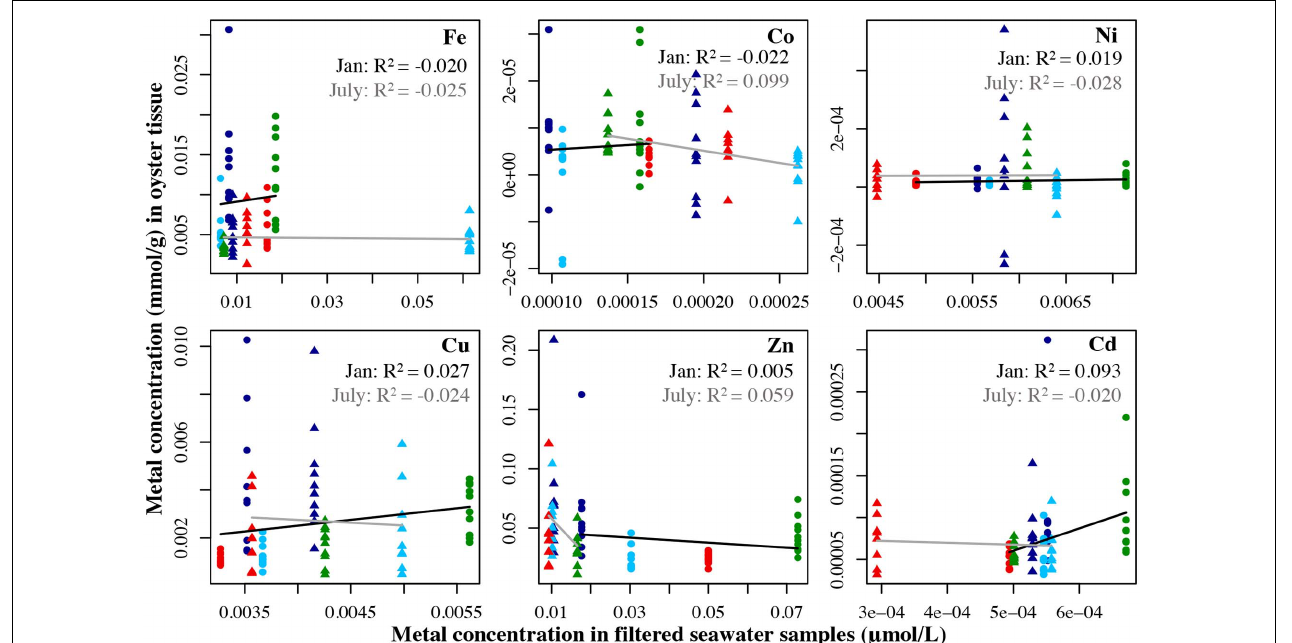
FIGURE 4 | Metal concentration ( µ mol/L) in filtered seawater samples from July 2018 and Jan 2019 plotted against the metal concentration the oyster tissue samples (mmol/g) from the four locations collected in July 2019 and Jan 2019. Circles represent the January samples, triangles represent the July samples. Dark blue = Carr Inlet 20 m, light blue = Carr Inlet 5 m, green = Point Wells 5 m, and red = Dabob Bay 5 m. Linear regression was used to assess the relationship between the two variables for Jan (black line) and July (gray line) separately.